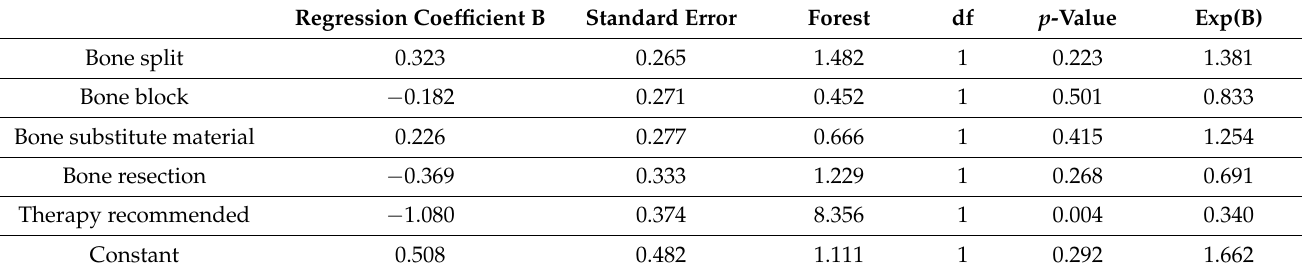
Table 4. Association between the dependent variable “smoking” (smoker vs. non-smoker) and the independent variables “bone split”, “bone block”, “bone substitute material”, “bone resection”, and “therapy recommended” for Case Vignette